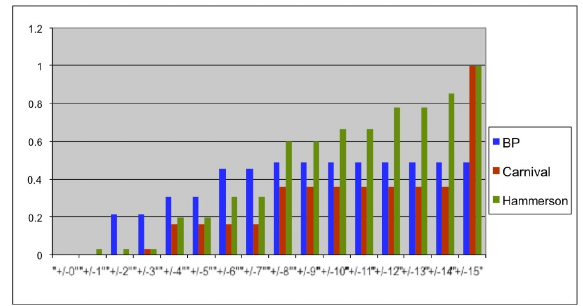
Figure 12 Percentage of EDDIE 8’s indicators that are close to EDDIE 7’s vocabulary, for the stocks that ED 8 Fit > ED 7 Fit . This percentage can be viewed in the y-axis. The x-axis presents the number of days that an EDDIE 8’s in- dicator is away from the pre-specified indicators of EDDIE 7.